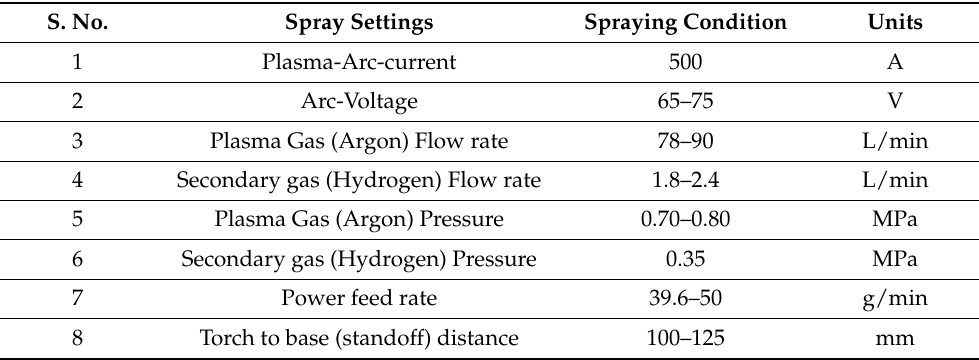
Table 3. Spraying parameters of APS